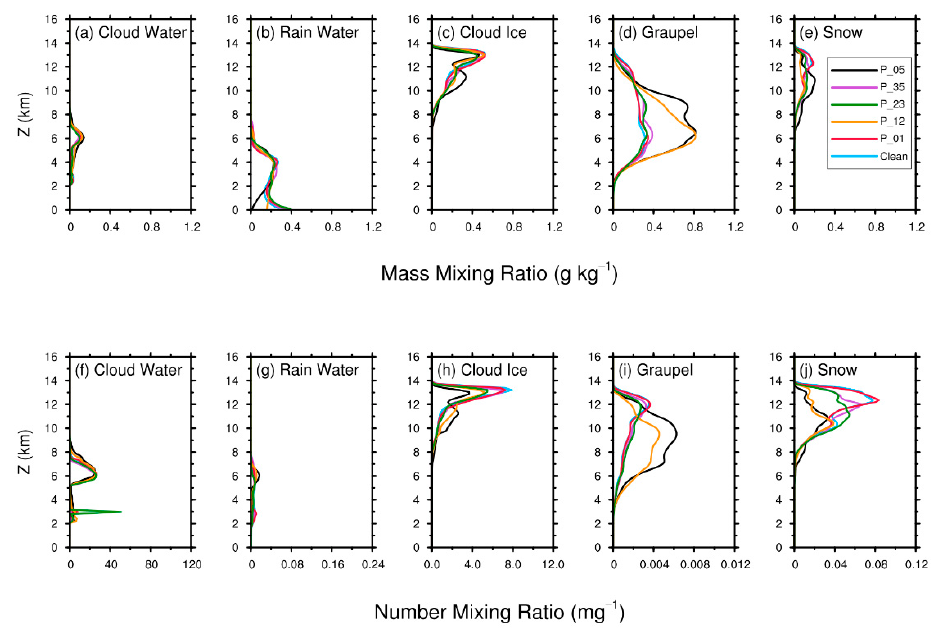
Figure 7. The same as Figure 6 but at 32 min. Upper row : the vertical profiles of mass mixing ratios of all hydrometeors. Bottom row : the vertical profiles of number mixing ratios of all hydrometeors.